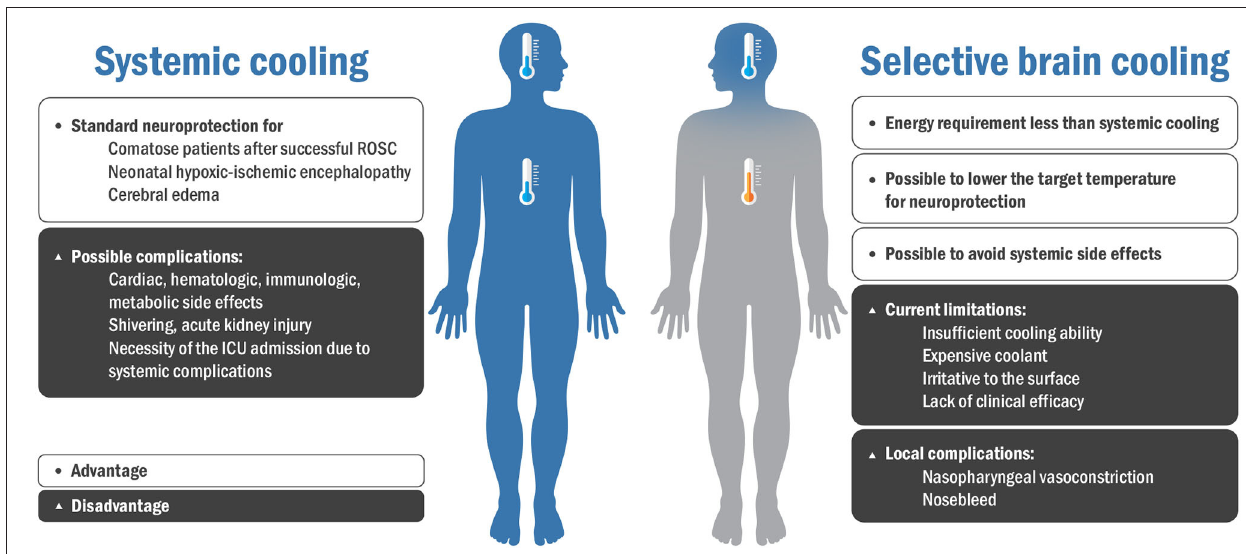
FIGURE 2 | Advantages and disadvantages of systemic cooling and selective brain cooling. ROSC, recovery of spontaneous circulation; ICU, intensive care unit.